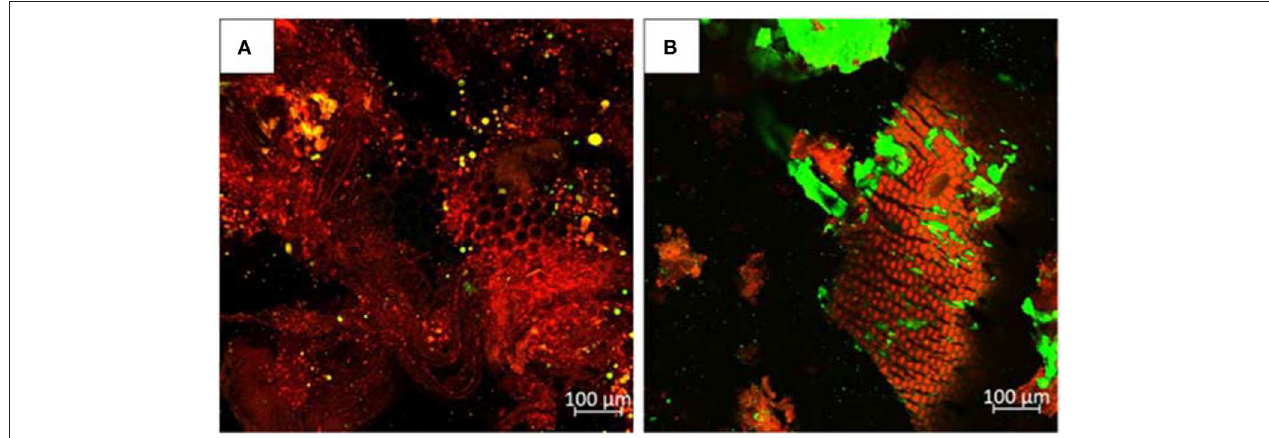
FIGURE 4 | Confocal microscopy of the BSF residues obtained by (A) WR; (B) BR. Red color indicates protein, green color indicates lipid.